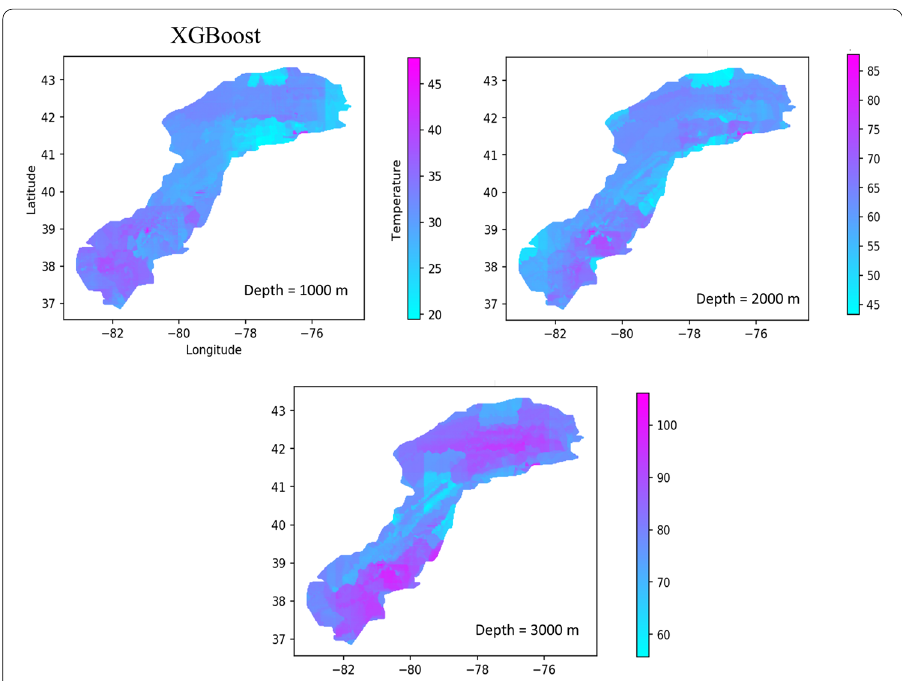
Fig. 7 Temperature map at three different depths using XGBoost model